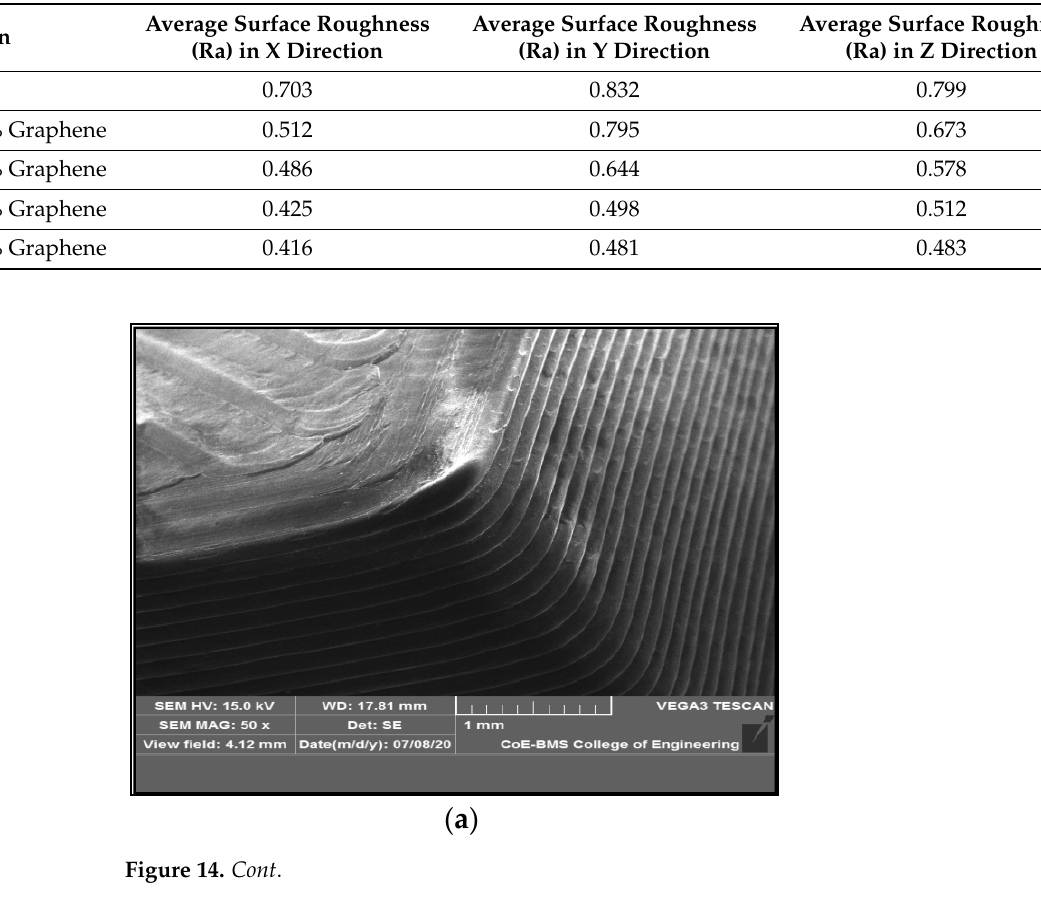
Figure 13. Variation of surface roughness with the addition of graphene in X direction (build direction). Table 1. Surface roughness (Ra) values of FDM parts.